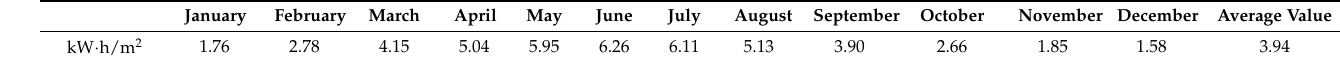
Table 8. Average monthly level of solar